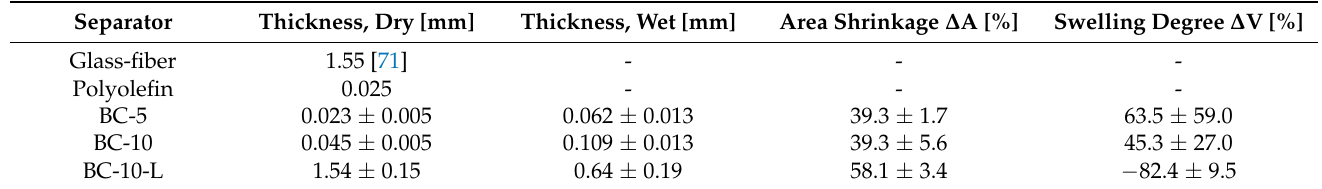
Figure 3. Produced separators via solution casting of ( a ) 5 and ( b ) 10 g L − 1 -based bacterial cellulose (BC) solutions or ( c ) freeze-drying of a 10 g L − 1 BC solution. Table 1. Dimensional properties of produced bacterial cellulose (BC) separators in comparison to commercial